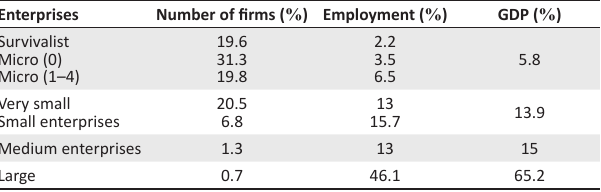
TABLE 1: Contribution of South Africa’s small and medium enterprises to the economy.